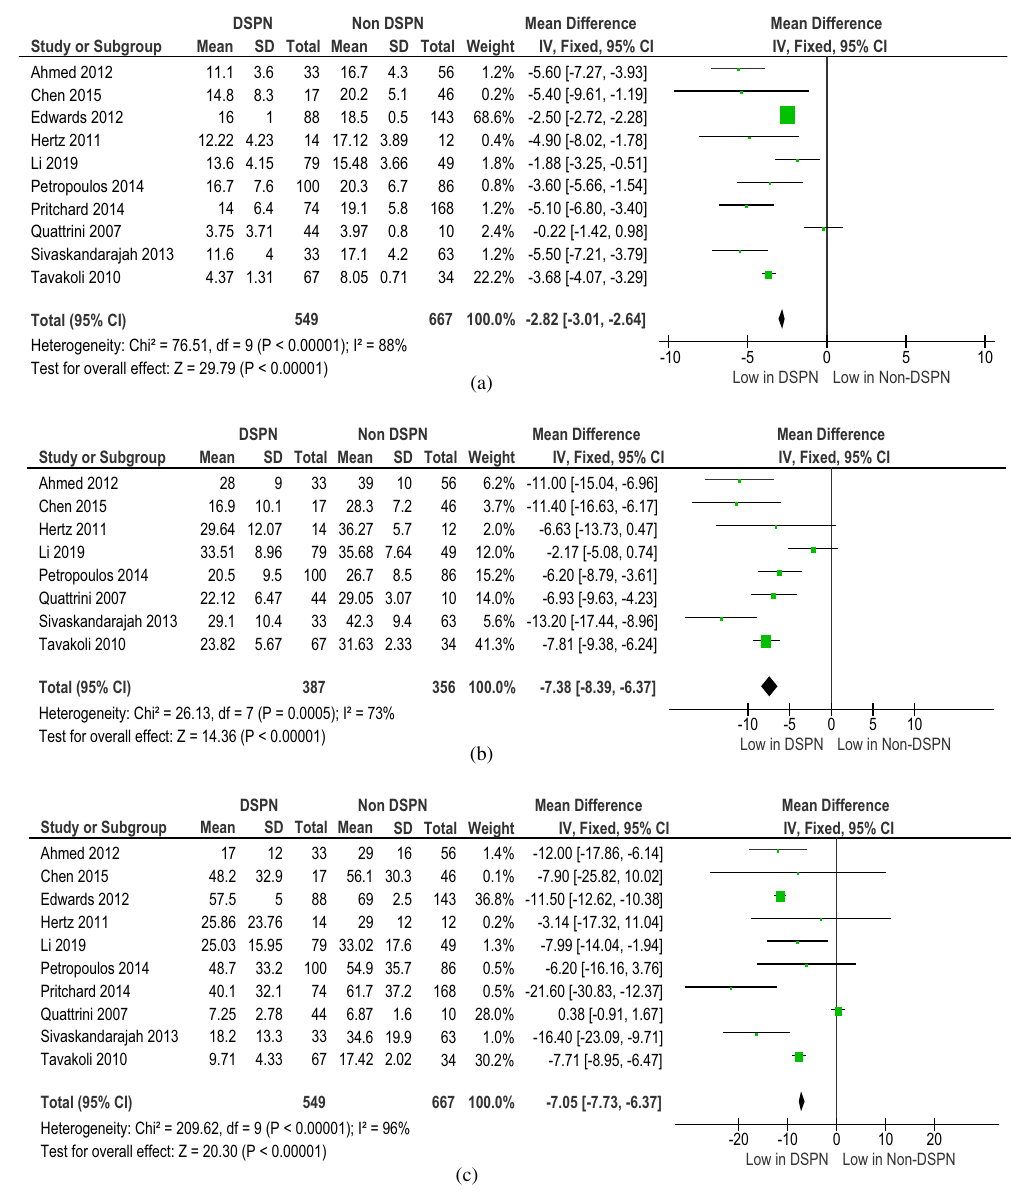
Figure 3. Forest plots for CCM diagnosis parameters comparing DSPN and Non-DSPN groups ( a ) CNFL, ( b ) CNFD, ( c )